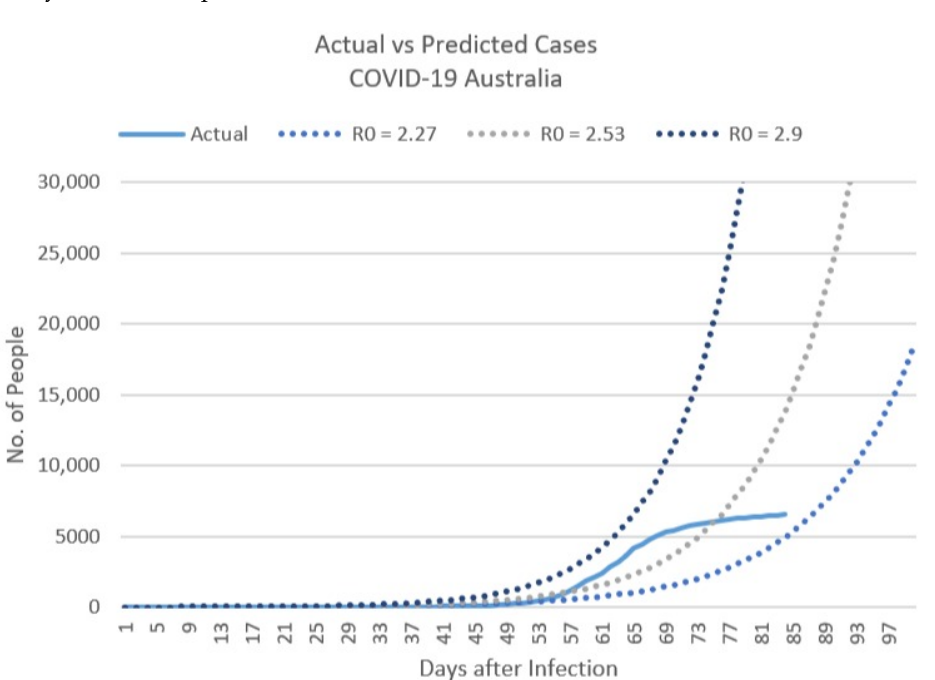
Figure 4. SEIR Model with rate of movement between categories.